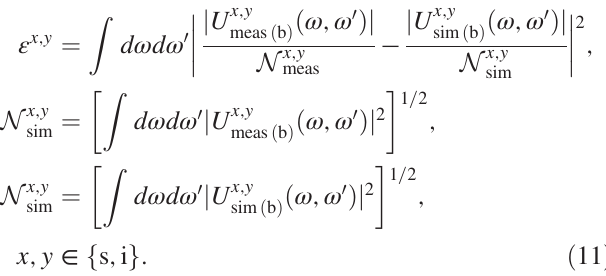
FIG. 5. Amplitudes of the same-mode TFs, U s ; s ð i ; i Þ Simulated same-mode TF for (a) Fourier-limited, (b) chirped, and (c) higher-order chirped Gaussian pump pulses (intensity and bandwidth in arbitrary units). A chirped pump causes a displace- ment of the same-mode TF from the diagonal (b), while a higher- order chirp leads to a more complicated deformation of the same-mode TF.